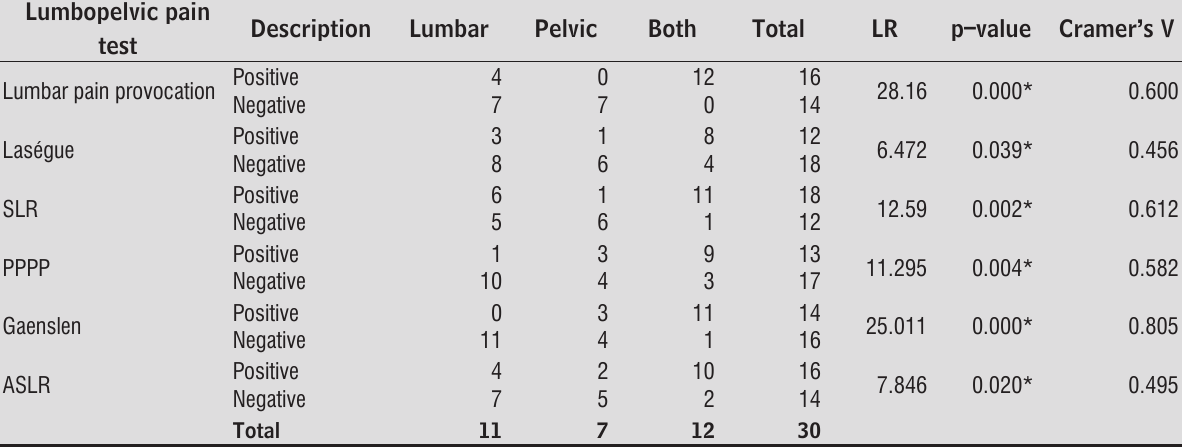
Table 2 - Association of symptoms and positivity in specific tests of gestational lumbopelvic pain with the origin/site of pain Lumbopelvic